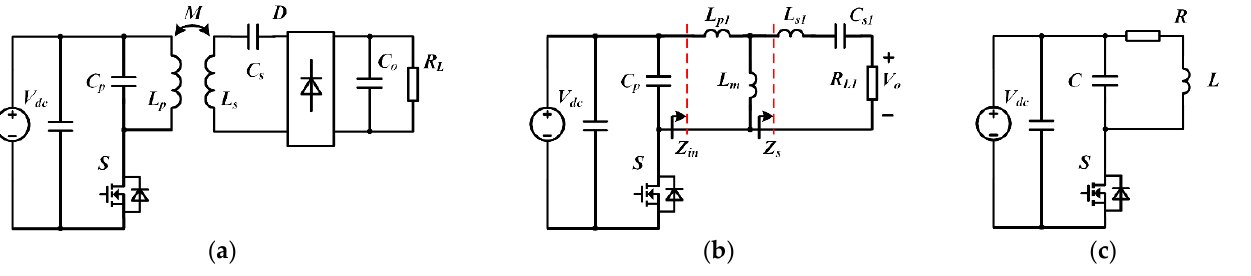
Figure 1. Typical configuration of the single-ended WPT systems: ( a ) single-ended resonant converter; ( b ) the transformer version equivalent circuit; ( c ) simplified model.